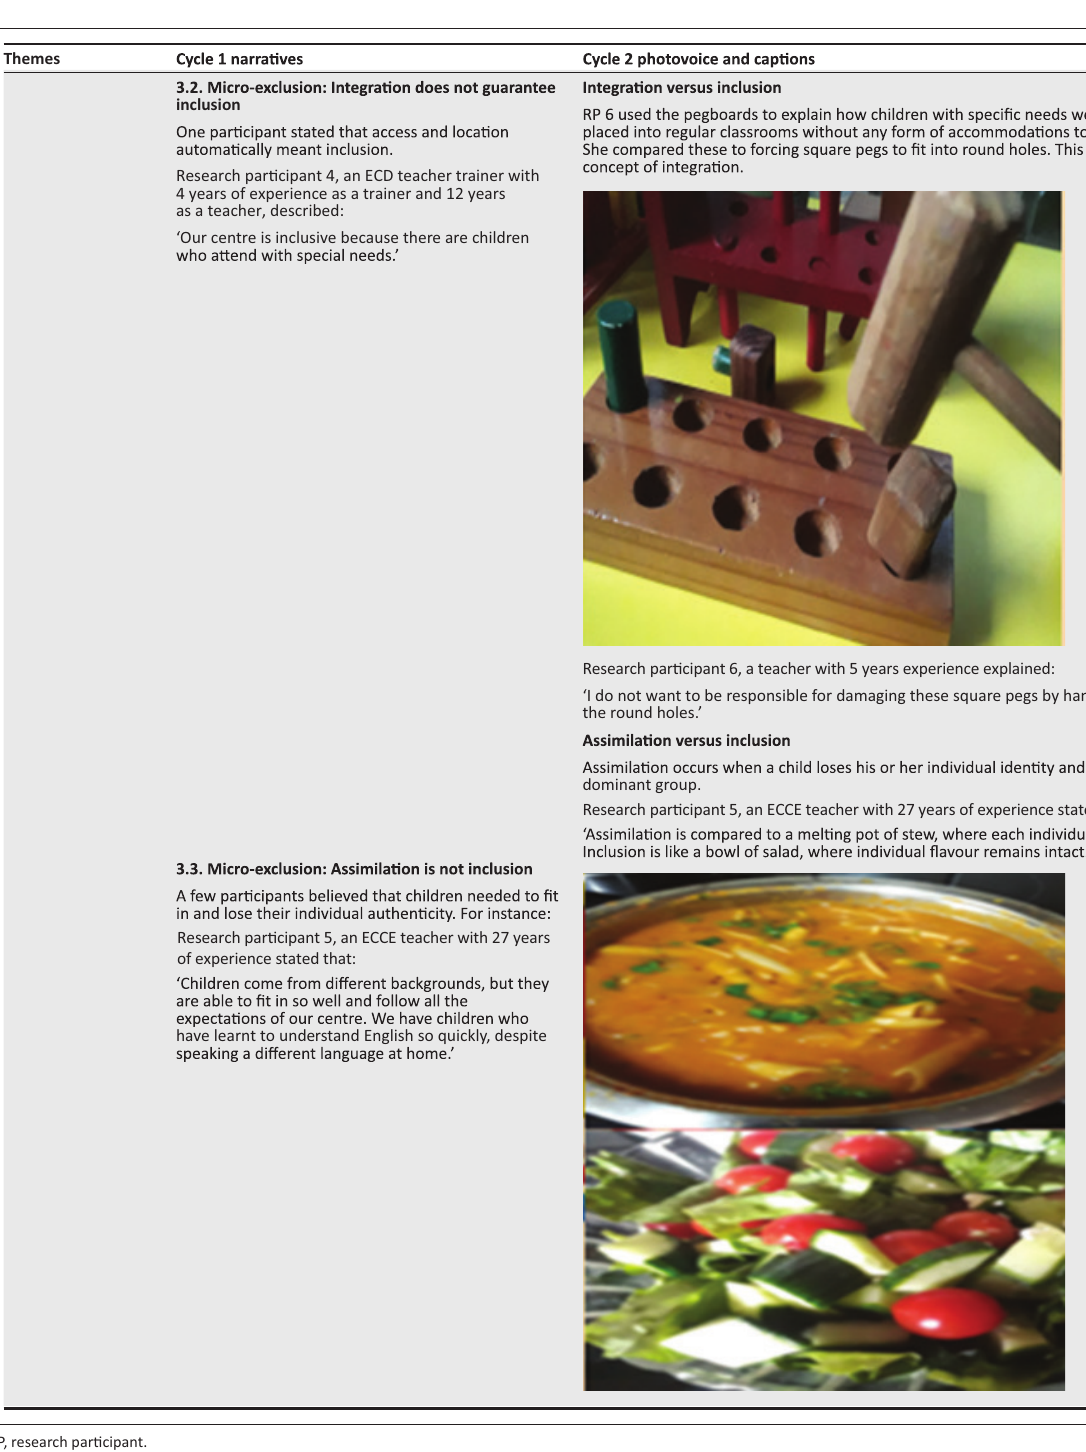
FIGURE 1 (Continues...): Participants’ photovoice, captions and narratives for cycles 1 and